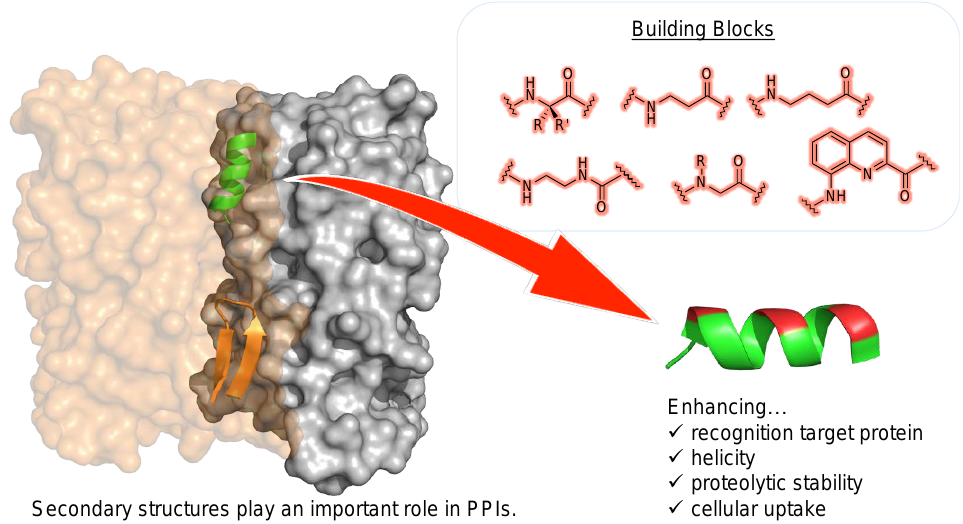
Figure 1. Inhibition of protein-protein interactions by peptide-based foldamers containing non-proteinogenic amino acids.